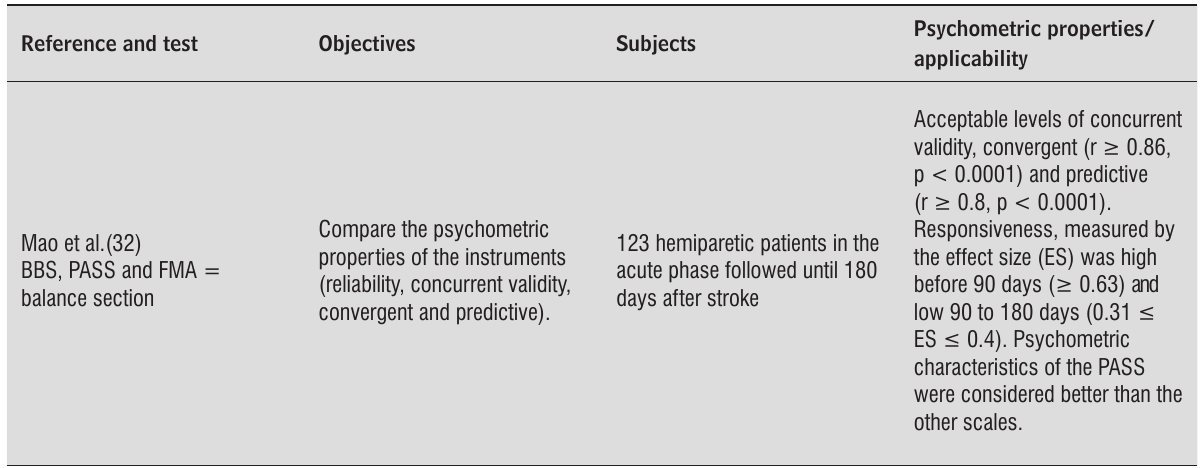
Table 2 - Studies of construct and concurrent